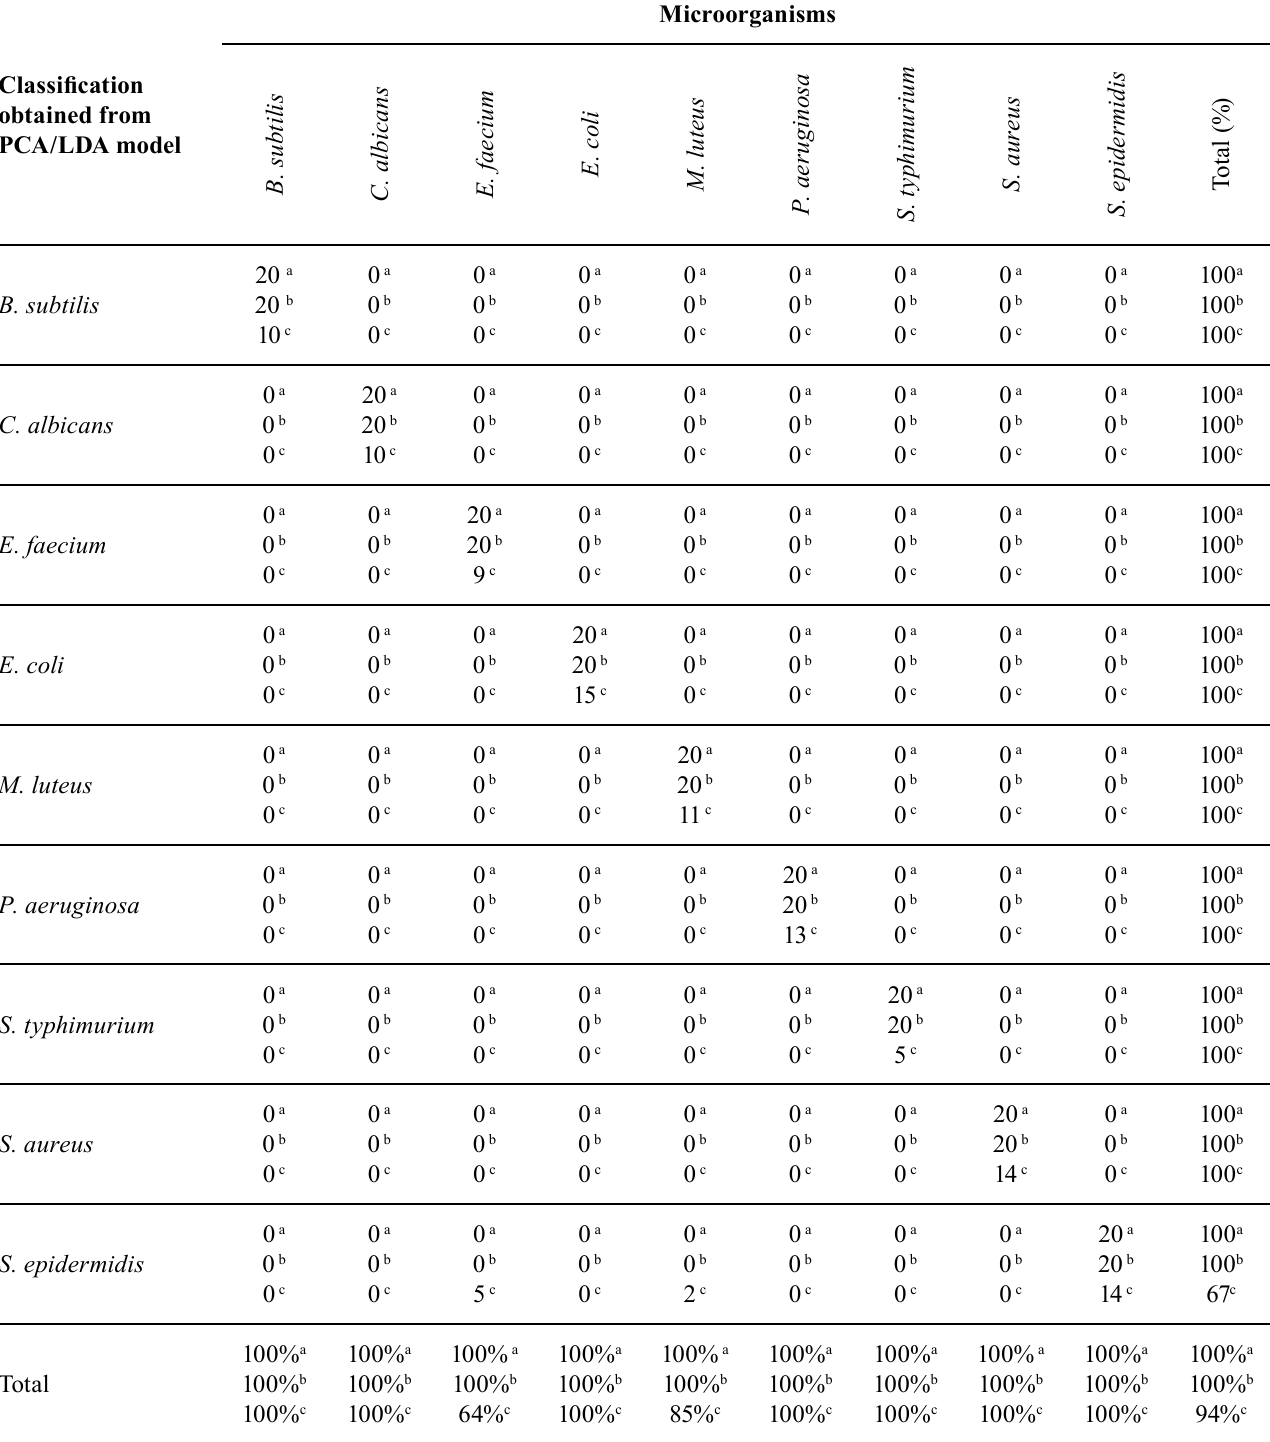
TABLE III – Confusion matrix for the LDA model obtained from FTIR-ATR spectra between 800 and 2000 cm -1 after first derivative and smoothing with 4 PC predictors